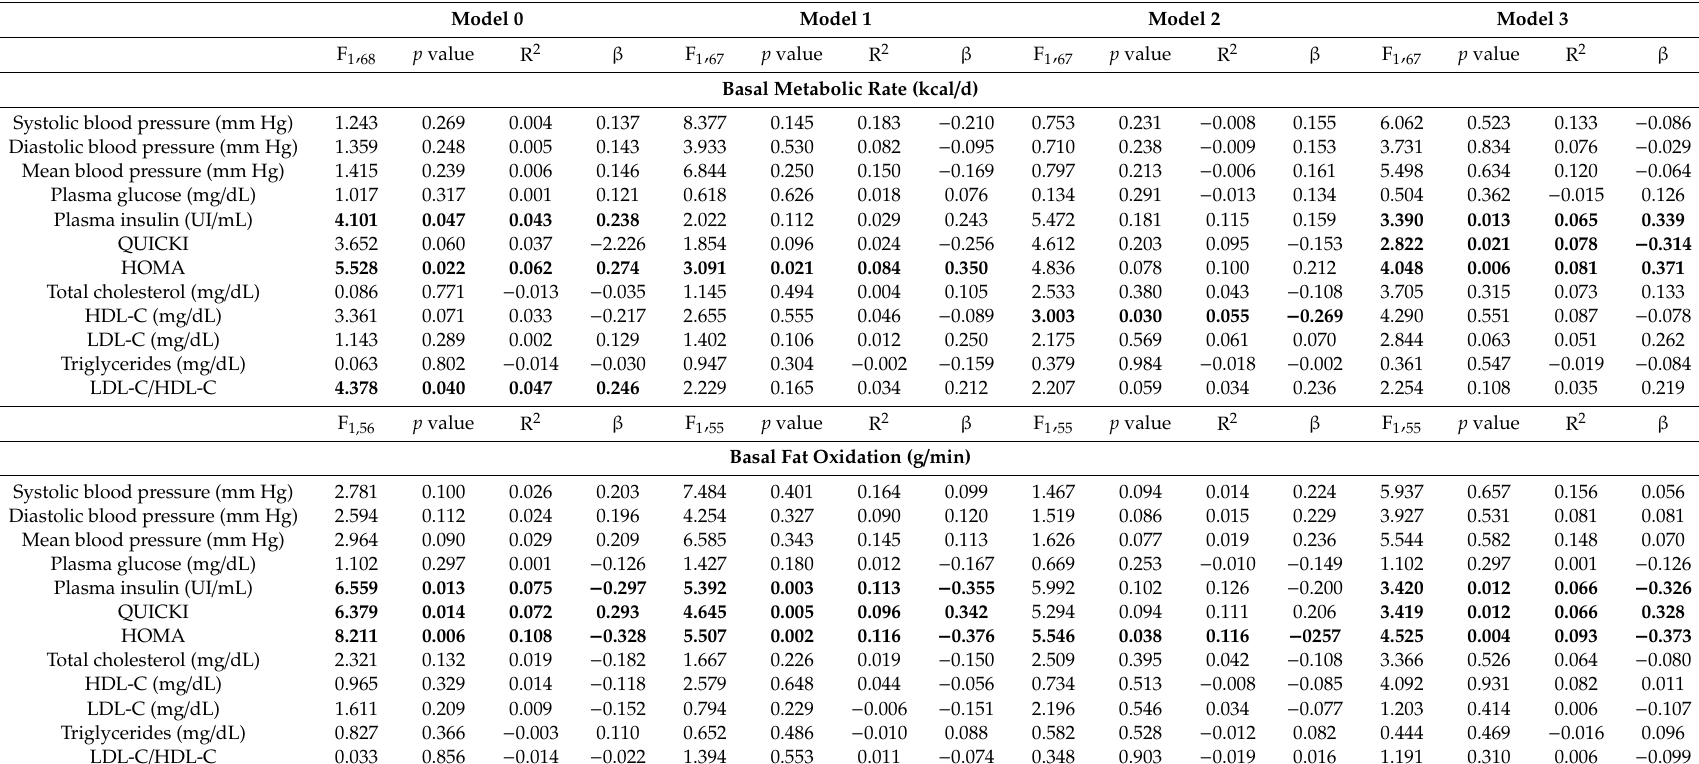
Table 2. Association of basal metabolic rate and basal fat oxidation with cardiometabolic risk